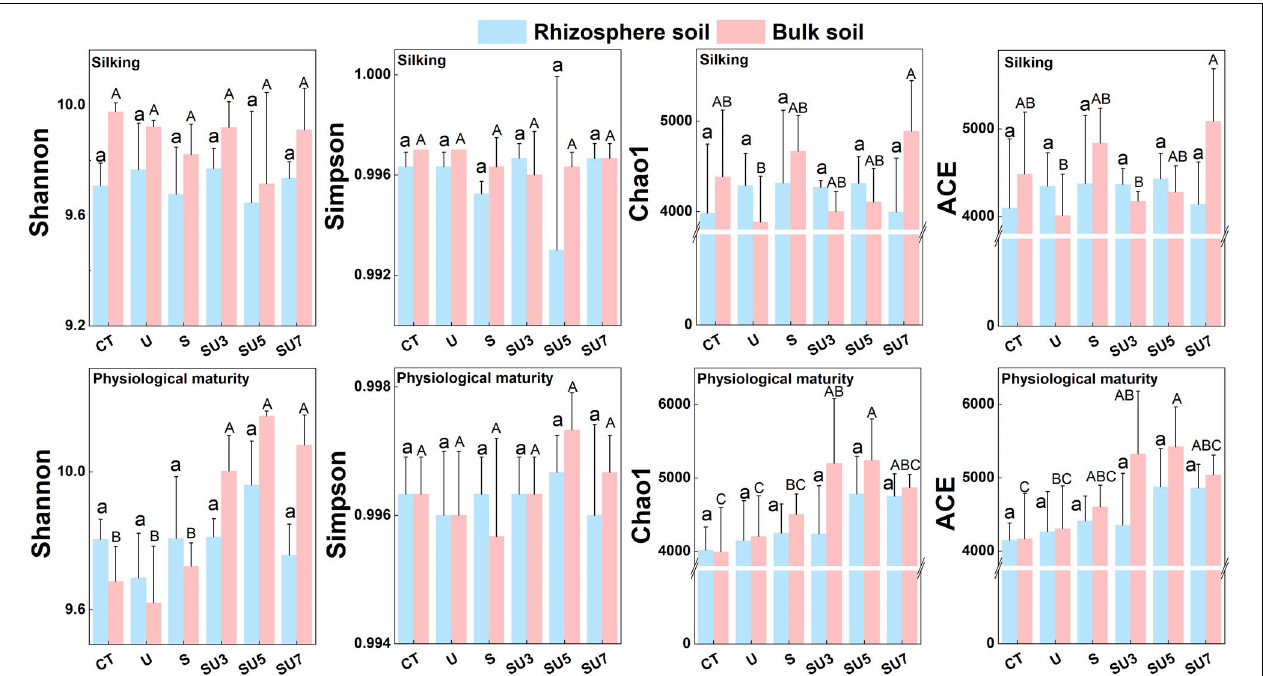
FIGURE 2 | Effect of CT, U, S, SU3, SU5, and SU7 in rhizosphere and bulk soil bacterial α -diversity (Shannon, Simpson, Chao1, and ACE indexes) at different maize growing stages (i.e., silking and physiological maturity). Regular urea, controlled-release urea, and different ratios of regular urea and controlled-release urea are all applied at a rate of 180 kg ha - 1 . Values are presented as the means ± SE. Lowercase and uppercase letters indicate significant differences between the nitrogen fertilizer treatment ( p <